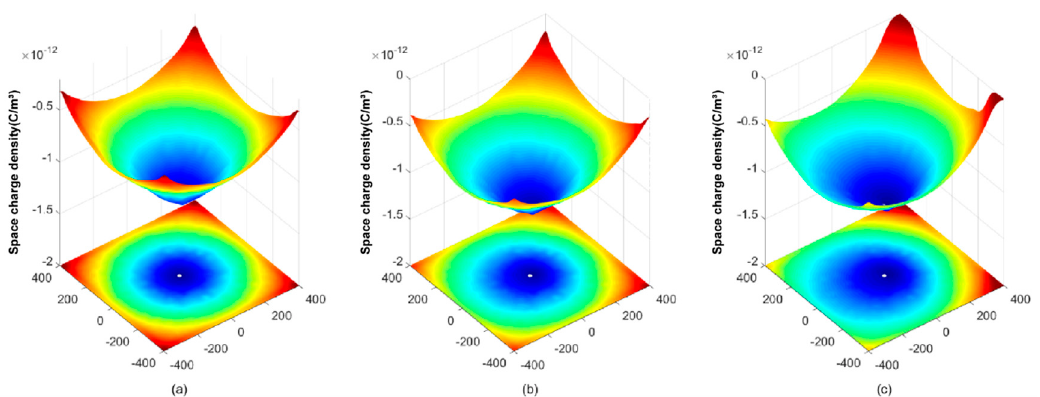
Figure 5. Space charge density under 100 kV supply voltage. ( a ) space charge density under 0 m/s wind speed; ( b ) space charge density under 5 m/s wind speed; and ( c ) space charge density under 10 m/s wind speed.